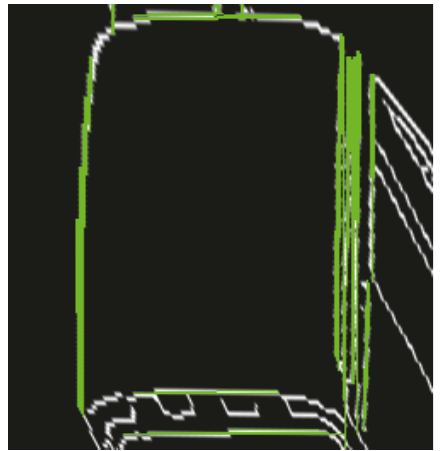
Figure 46: Extraction result of the line in the top view of van.